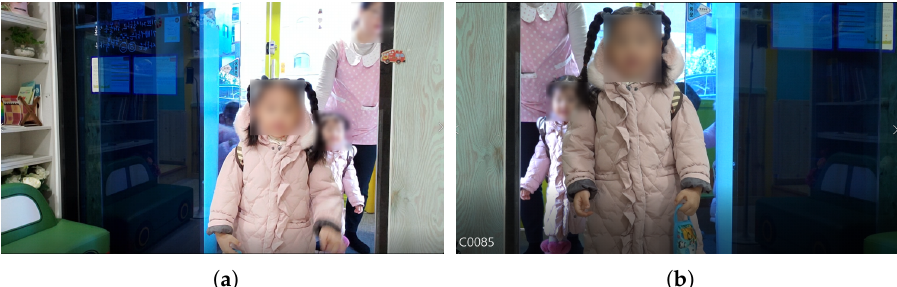
Figure 15. Actual captured images in Figure 14: ( a ) tablet PC; ( b ) smartphone. Finally, the tablet and camera were installed in the same location as in the third test, and another smartphone rear camera was installed next to the door (Figure 16). The smartphone’s rear camera was installed in consideration of children walking backwards while greeting their parents or friends at the door. The filming lasted about two and a half hours, from 8:00 to 10:30 a.m. The camera installation results are shown in Figure 17. In this set-up, the smartphone installation location was not appropriate because the teacher often covers the children’s faces while greeting them at the entrance. Therefore, it was confirmed that this location was not efficient because the child’s face was seen less relative to the filming time.